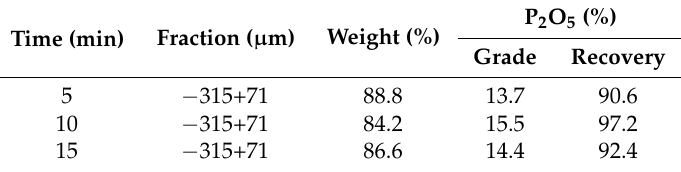
Table 6. Chemical analysis after scrubbing and attrition treatments.